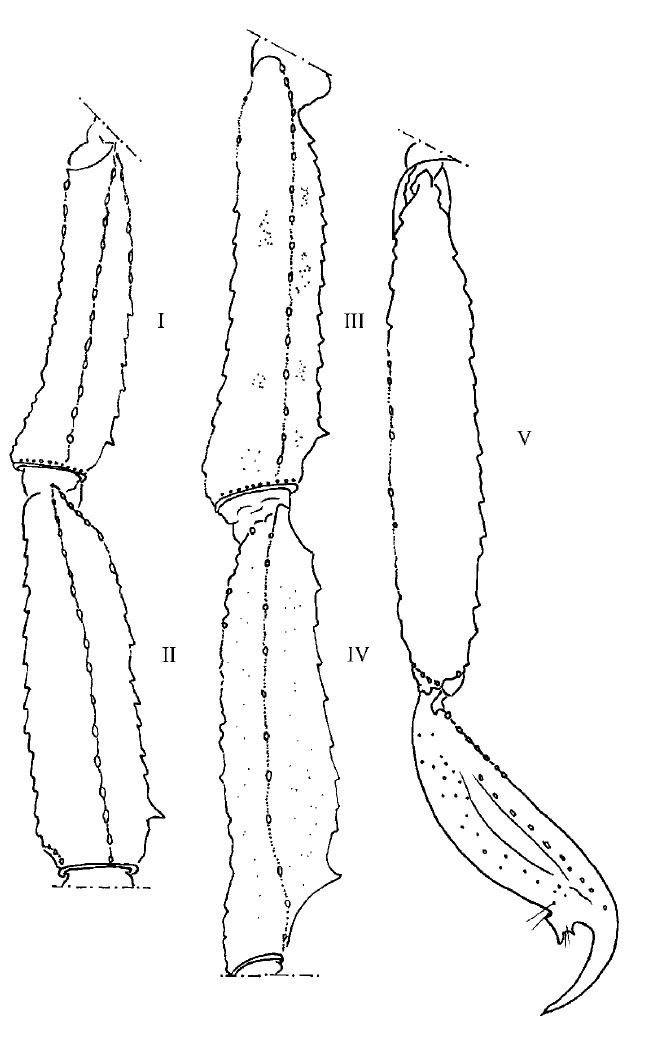
Figure 5 . Tityus gonzalespongai n. sp . Male. Caudal segments I-V and telson. Lateral